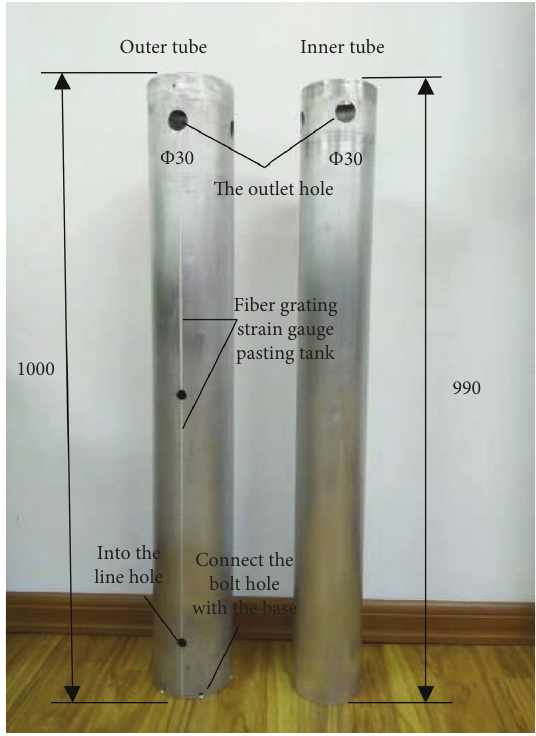
Figure 3: The inner and outer tubes of double-walled open-ended pile.